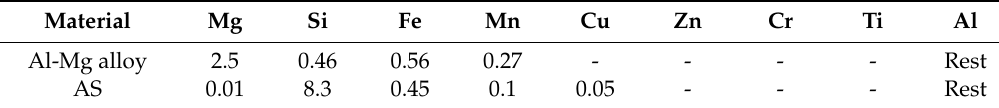
Table 1. Elemental chemical composition (% in weight) of the Al-Mg alloy and aluminized steel (AS) samples used in this